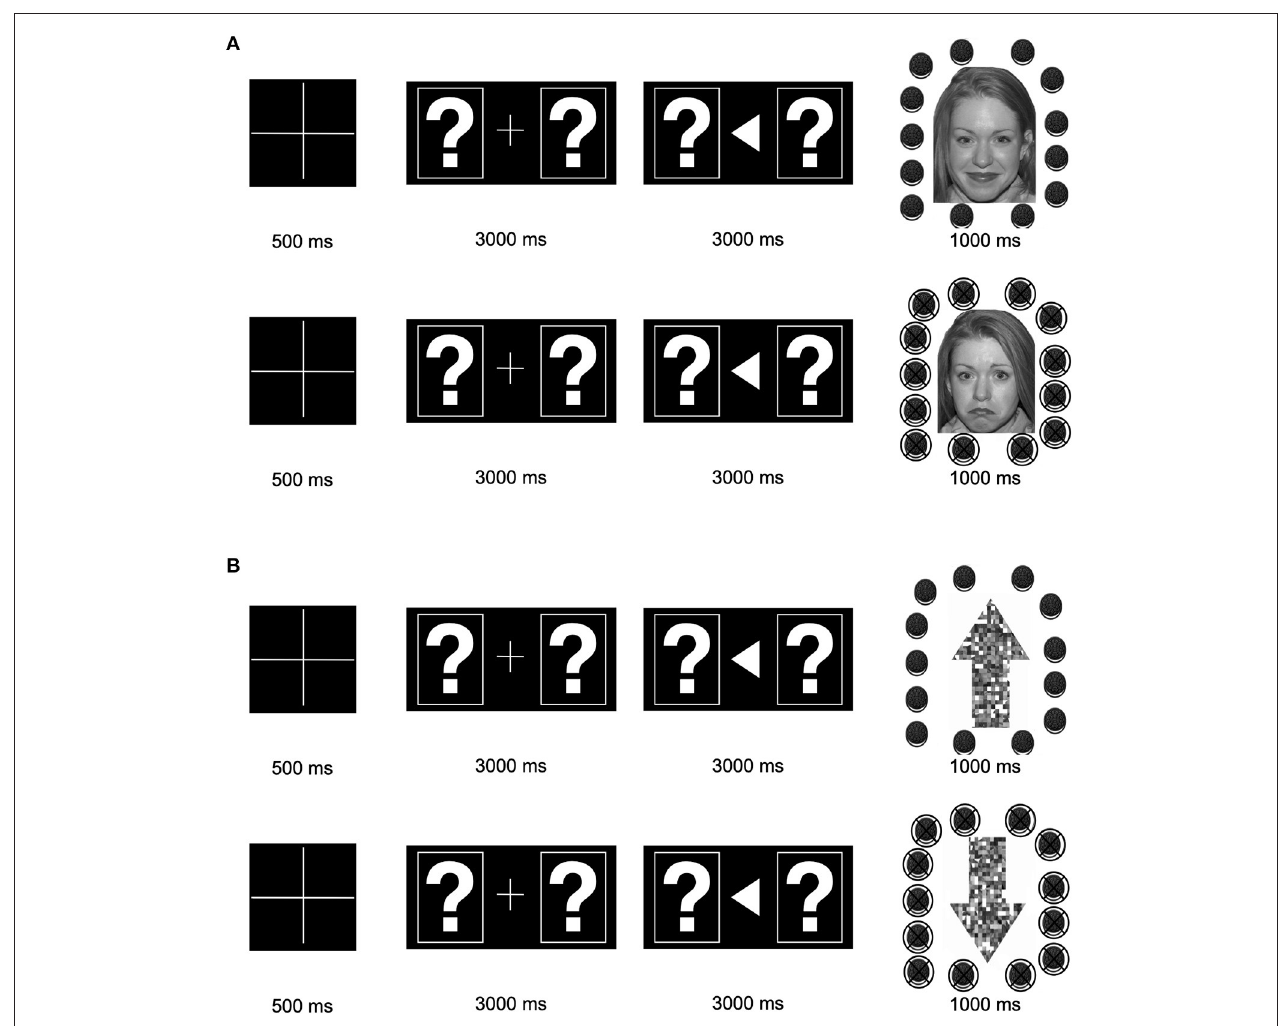
FIGURE 1 | Stimulus presentation: (A) Stimuli and presentation timing for the social condition. (B) Stimuli and presentation timing for the non-social condition. Correct feedback is shown on top (intact Oreos); incorrect feedback is shown on the bottom (crossed-out Oreos).